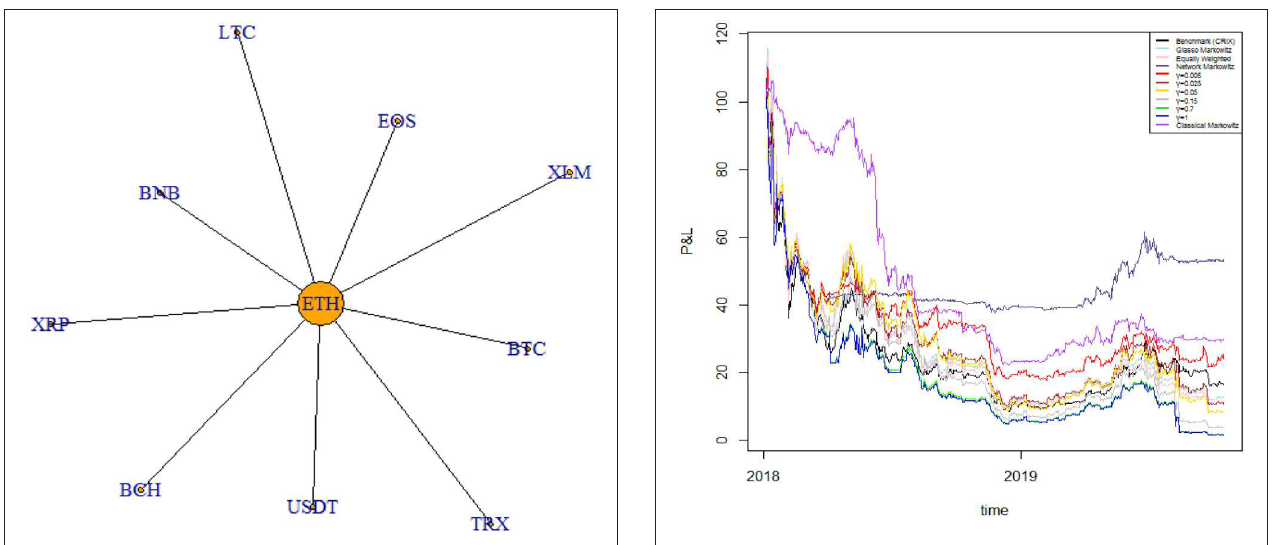
FIGURE 6 | Performances of different portfolio strategies. The plot reports the profits and losses of a portfolio with initial value of 100 USD obtained by the CRIX benchmark index [Benchmark (CRIX)], the optimization using the Markowitz approach with the variance-covariance matrix filtered by Glasso (Glasso Markowitz), the naive portfolio (Equally Weighted), our optimization using RMT and MST applied to the variance-covariance matrix (Network Markowitz), our model based on different values of γ ( γ = 0.005, 0.025, 0.05, 0.15, 0.7, 1), and the standard Markowitz portfolio (Classical Markowitz). The portfolio values are plotted for the period 7 January 2018–17 October 2019.